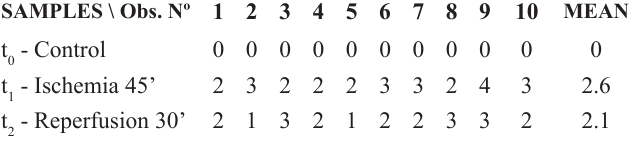
TABLE 2 - Histopathology of Group 2 animals with ischemic preconditioning.